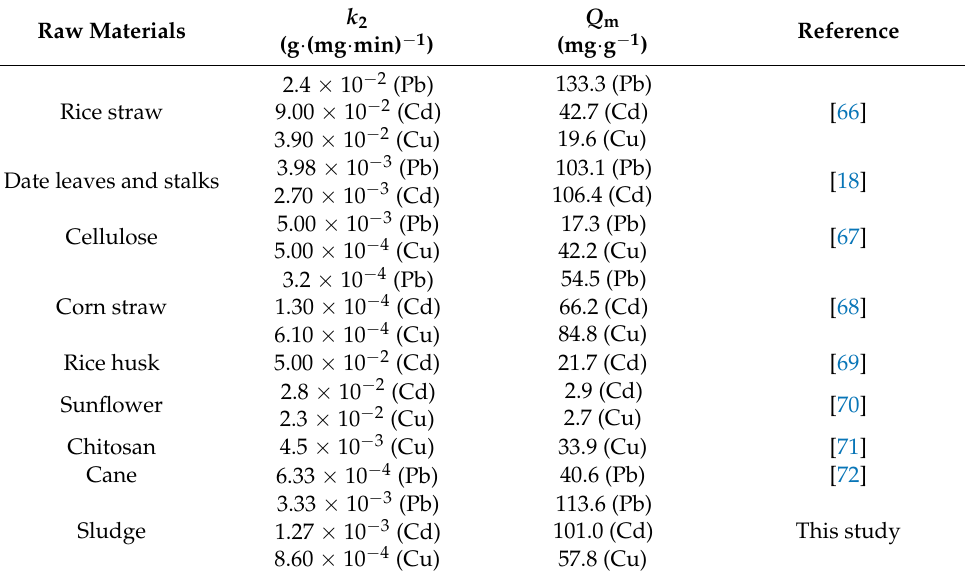
Table 5. Comparison of Q m and k 2 between MSBC-2 and various magnetic